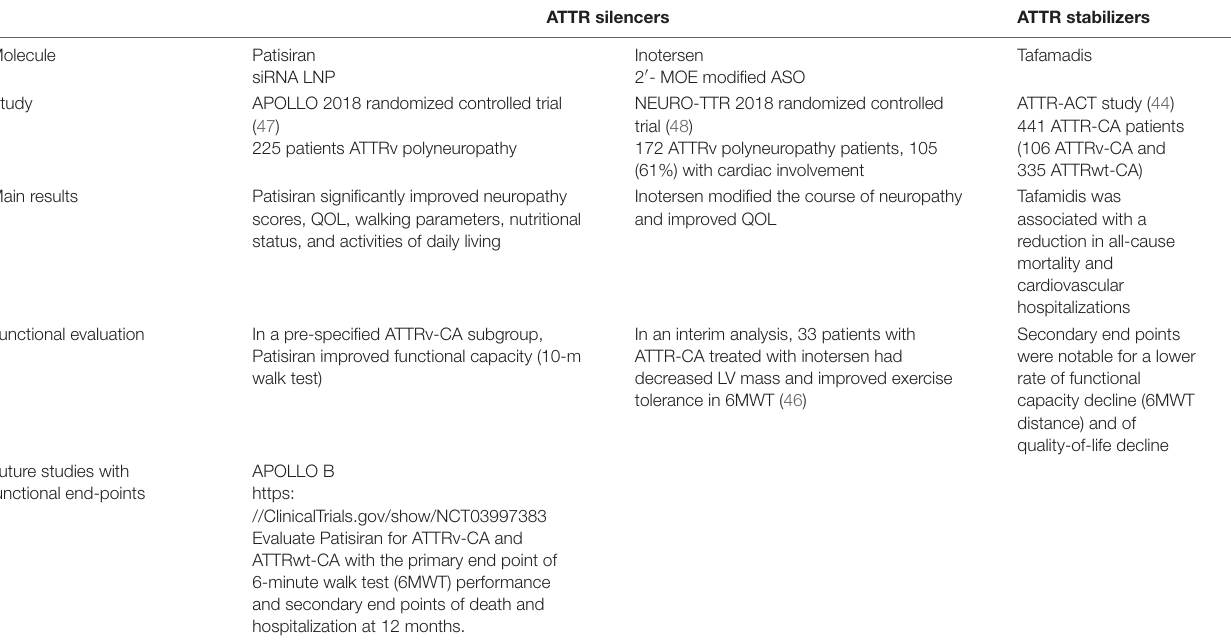
TABLE 2 | Main studies evaluating treatment for transthyretin (TTR) CA with functional end-points.